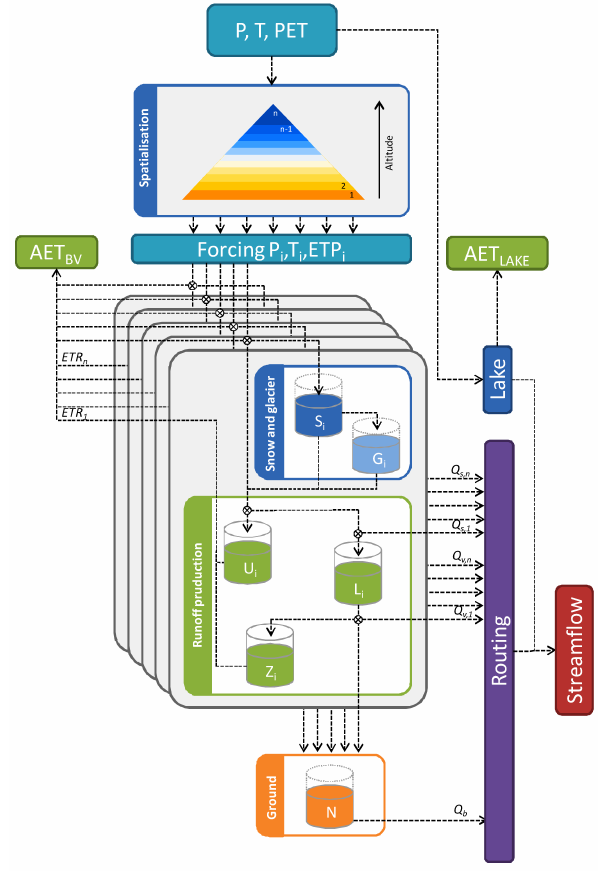
Figure A1. Overview of MORDOR SD model components and